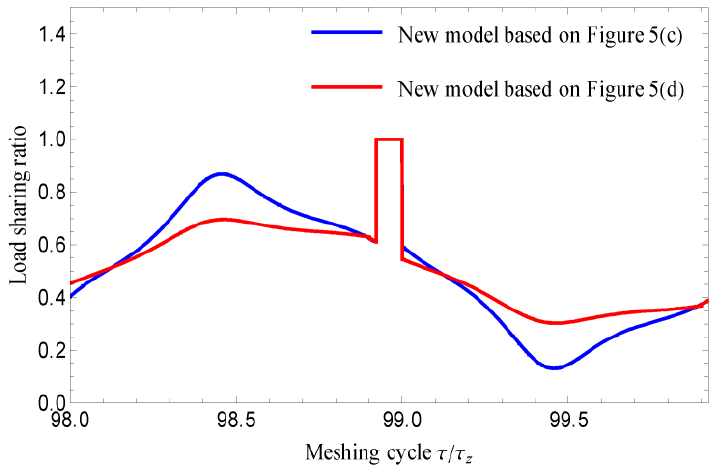
Figure 9. Load sharing ratio based on new dynamic model.